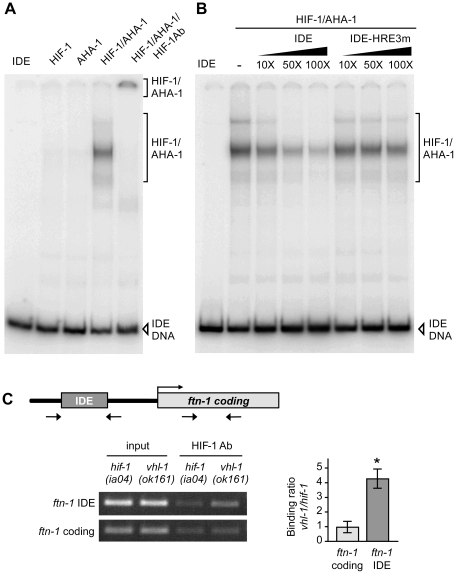
HIF-1 binds to the ftn-1 IDE in vitro and in vivo.(A) HIF-1 and AHA-1 synthesized in reticulocyte lysates were incubated singly or together with a 32P-labeled ftn-1 IDE probe. HIF-1/AHA-1/IDE complexes were analyzed by non-denaturing polyacrylamide gels. Free IDE probe and HIF-1/AHA-1/IDE complexes are indicated. HIF-1 antibody was added to the reaction (lane 5). (B) 32P-labeled IDE probe was incubated with HIF-1/AHA-1 with increasing molar amounts of unlabeled wildtype IDE or mutant IDE-HRE3m. (C) Diagram of the location of the IDE in the ftn-1 promoter and the location of the primers used for amplification. ChIP was performed with chromatin isolated from a mixed-staged population of vhl-1(ok161) animals constitutively expressing HIF-1 or hif-1(iao4) animals. Chromatin was immunoprecipitated with CeHIF-1 antibody and bound DNA sequences were analyzed by qPCR using IDE or coding region primers. Chromatin extract (input) was amplified to determine the total amount of genomic DNA prior to immunoprecipitation. The binding of HIF-1 to the IDE is expressed as a ratio of binding in vhl-1(ok161) versus hif-1(ia04) ± SEM, *p = 0.019. A representative gel of three independent experiments is shown.